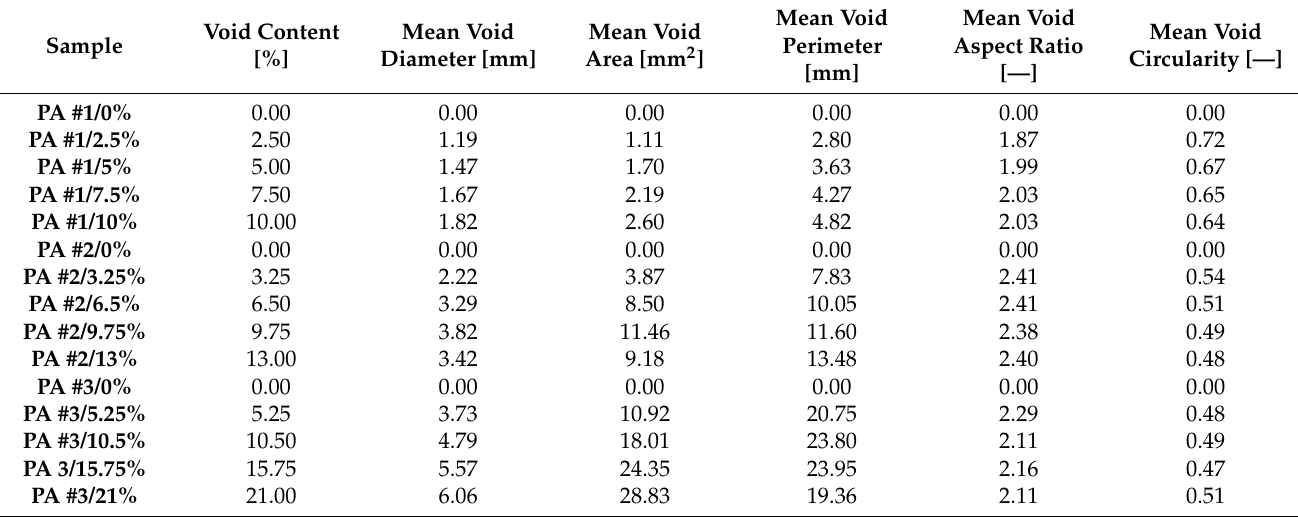
Table 4. Topological properties of the voids calculated from the